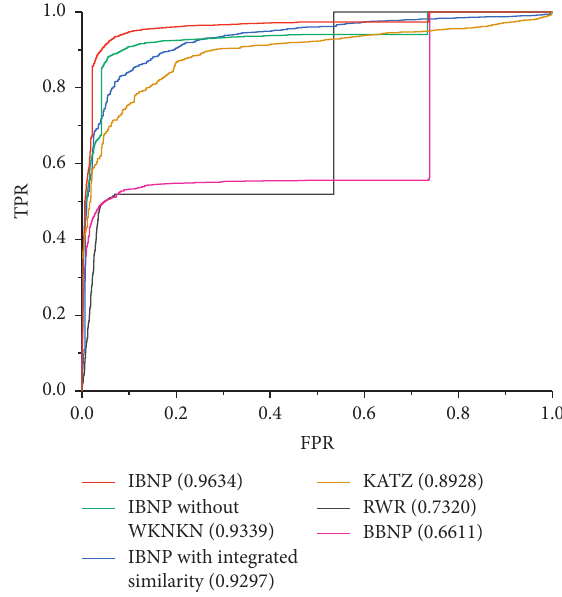
Figure 3: The ROC about LOOCV.